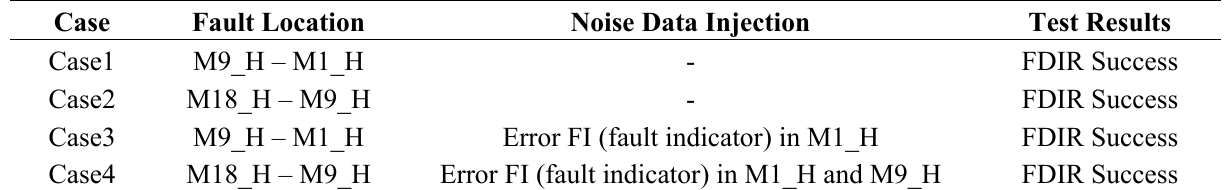
Table 11. FDIR test results of Gochang PTC.